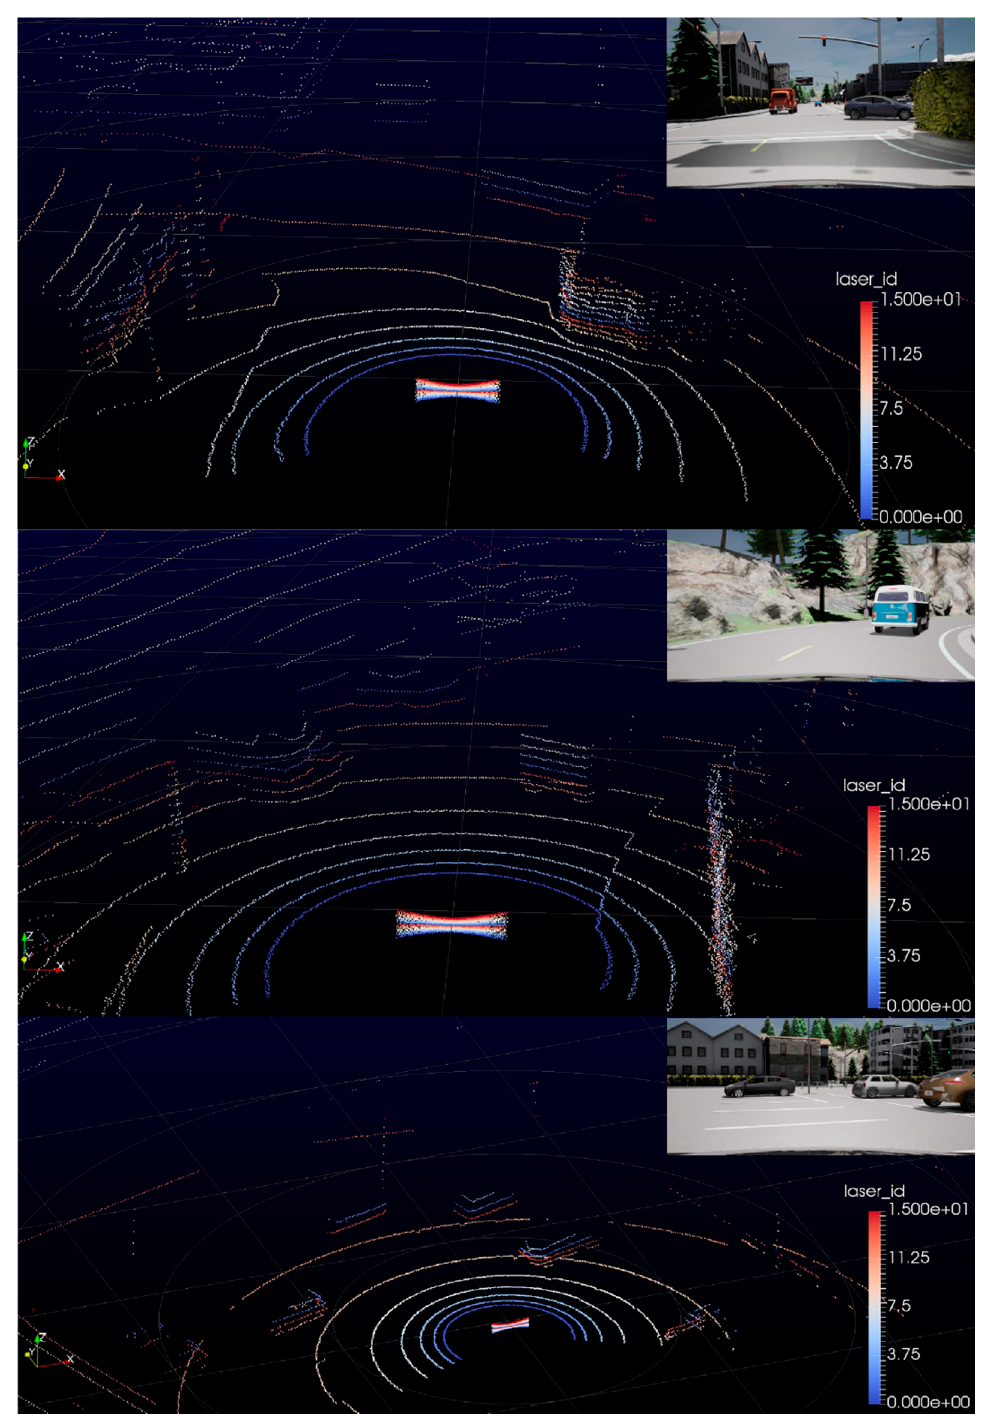
Figure 15. Velodyne VLP-16 lidar simulation visualized in manufacturer software tool VeloView. Simulation works as expected, moreover, the point cloud is rendered in real-time by VeloView. In the images, it is visible how the distance of each point is randomized re- sulting in slight noisiness.